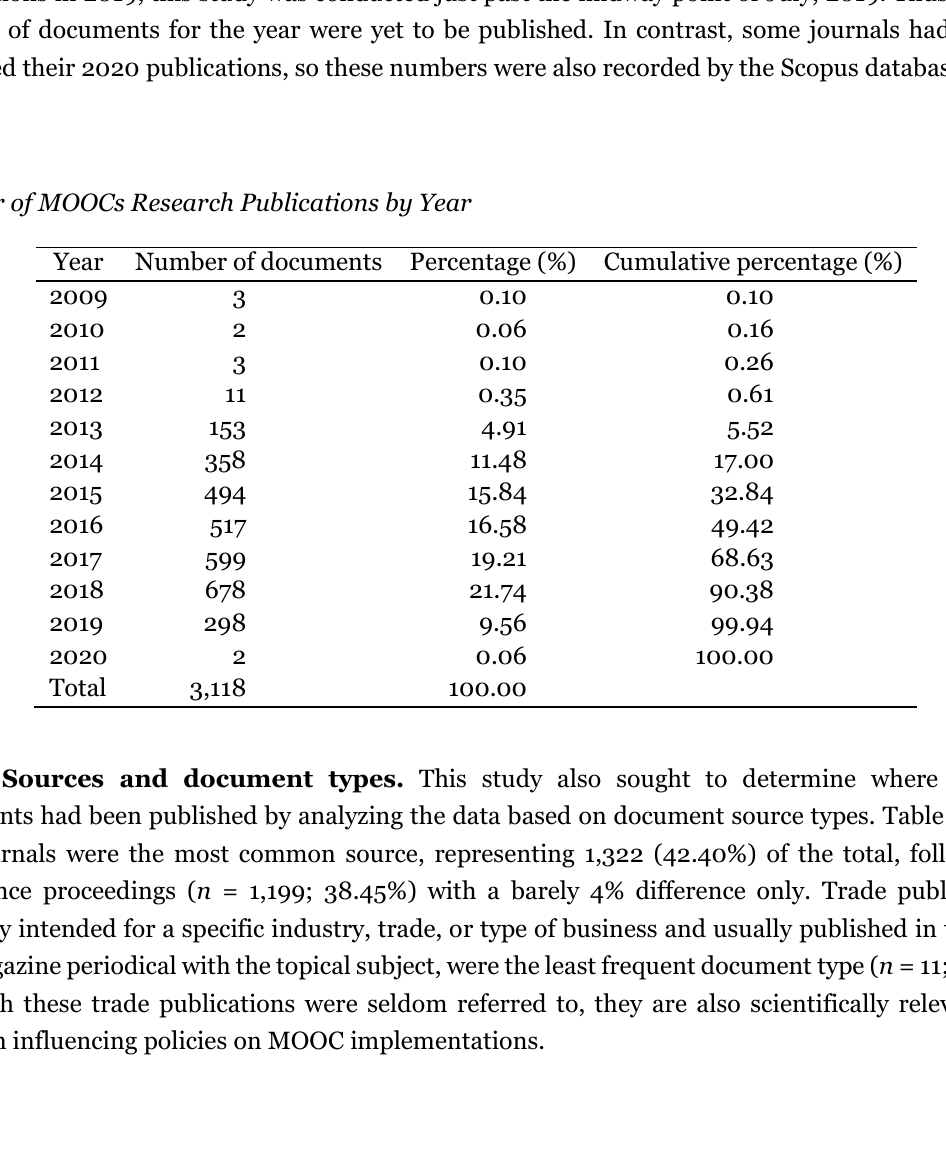
Sources for MOOCs